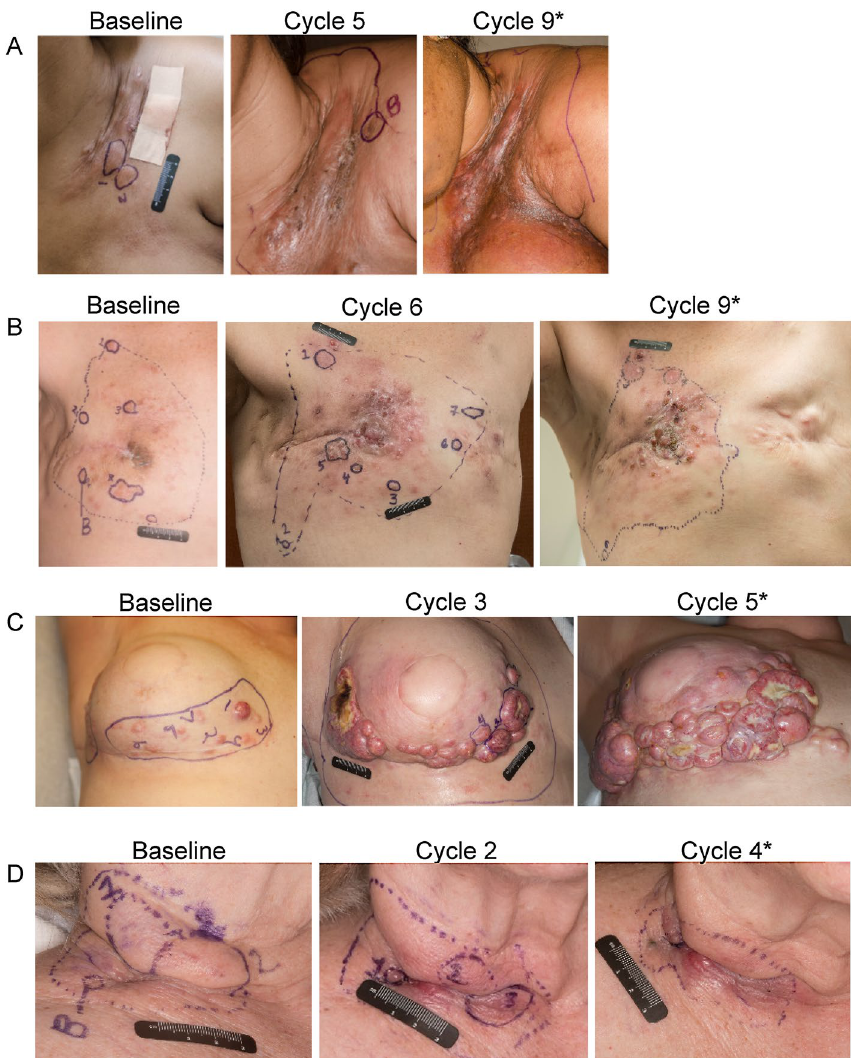
Figure 2. Representative clinical photographs showing the extent of local disease at baseline and before the indicated cycles of T-VEC treatment. Each row corresponds to a single patient. Local reactions after treatment initiation included ( A ) skin scabbing, flattening of lesions, edema, skin thickening, and hyperpigmentation; ( B ) hyperpigmentation, skin thickening, and new lesions; ( C ) increase in tumor burden/new lesions, erythema, and necrosis in tumor; and ( D ) edema, erythema, skin scabbing, and hyperpigmentation. *Patient did not proceed with